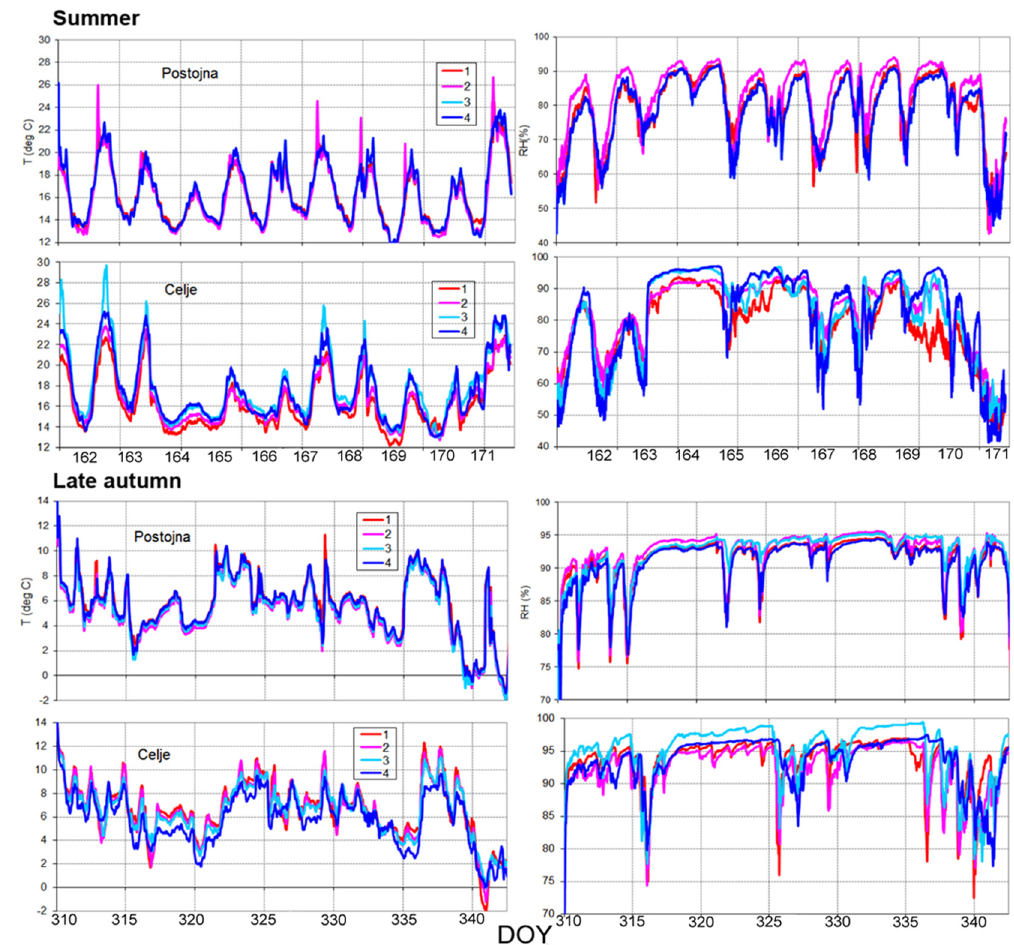
Figure 5. Dynamics of temperature (°C) and humidity (RH%) in summer (upper part) and late autumn (lower part) periods from the highest (1) to the lowest micro site (4).